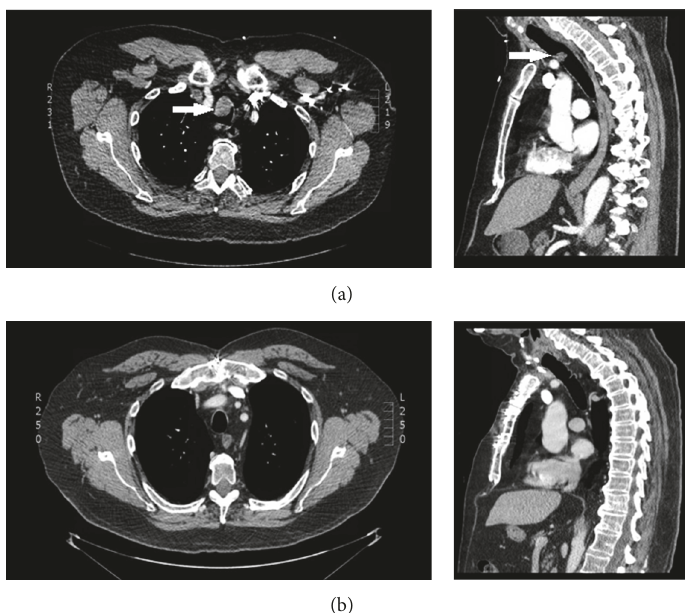
Figure 1: CT scan preoperative axial and sagittal views of the tumor (white arrows, (a)); postoperative views of resected trachea